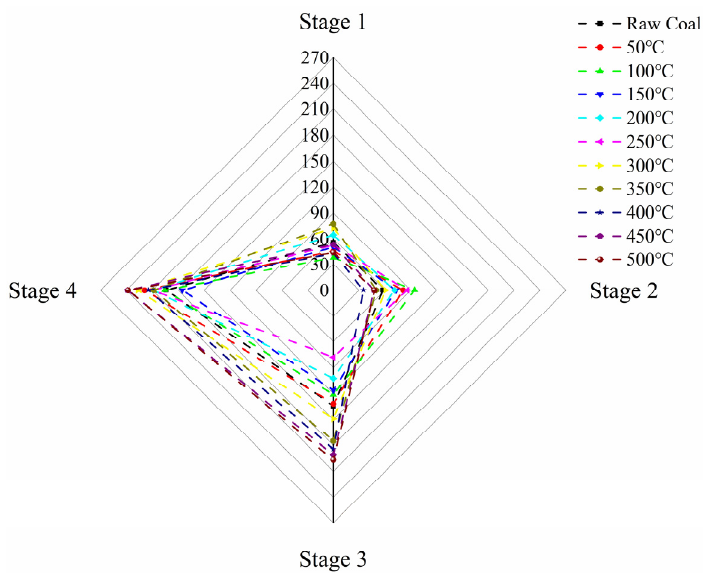
Figure 10. Activation energy change with different oxidized coal samples.